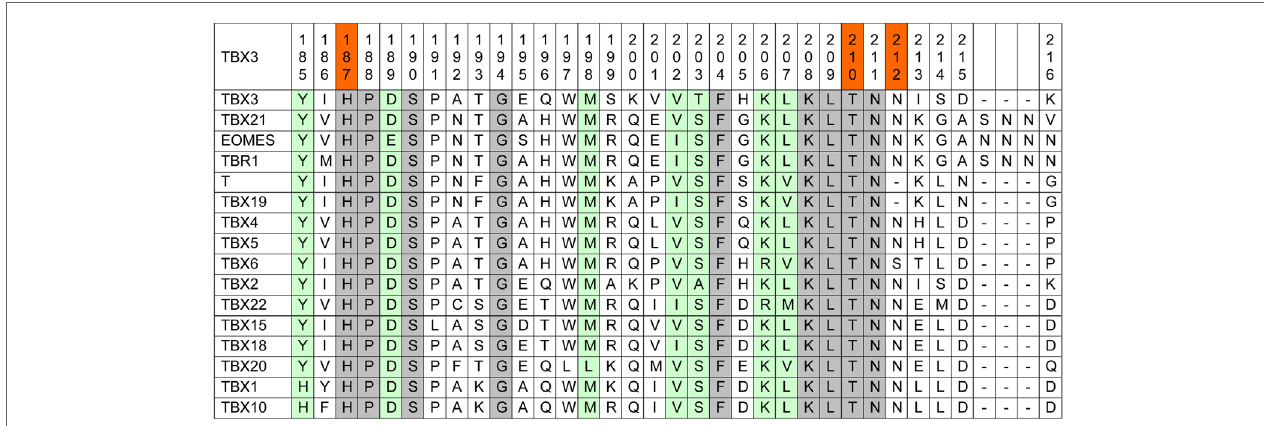
FigUre 1 | human TBX proteins in alignment with TBX3 . About one-sixth of the T-box, containing the mutations under consideration, is shown (TBX3 from 185 to 216). The complete TBX3 T-box encompasses residues 104–288 (66). Fully conserved amino acids are marked gray and T-box positions containing similar amino acids are green. In the top line, the three investigated mutations are marked